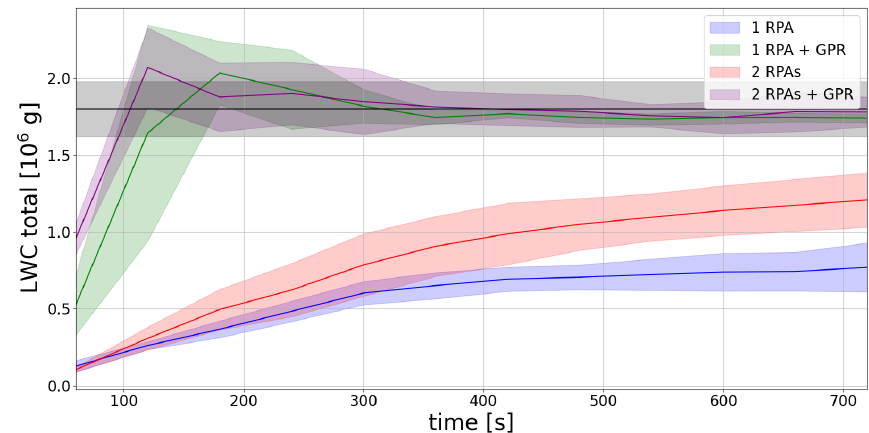
Figure 11. Temporal evolution of reconstructed LWC total with the transect method with one RPA (blue line) or two RPA (red line) and with the GPR method with λ x = 75m for a single RPA (green line) and two RPA (purple line). Colored shading areas represent LWC tot ± standard deviation for the 10 explorations for each 60s. The black line corresponds to reference LWC tot in the cloud N2 section in static state at 700m, and the shaded gray area corresponds to ± 10% of LWC tot .